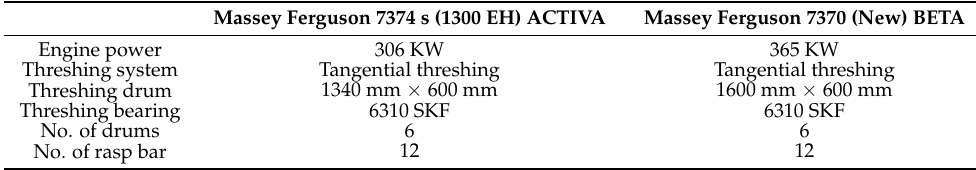
Table 1. Threshing unit technical parameters of the Activa and Beta version of Massey Ferguson.